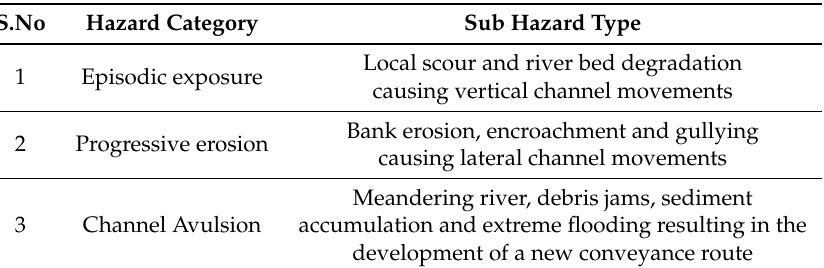
Table 2. Classification of river bed erosion phenomenon.